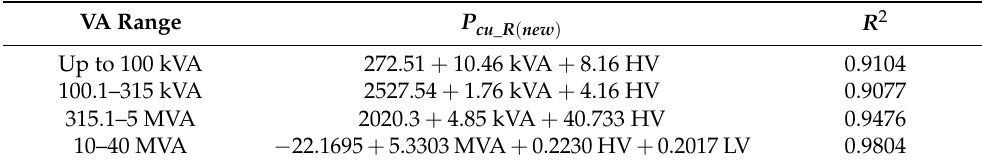
Table 4. Proposed regression models for P cu _ R ( new )